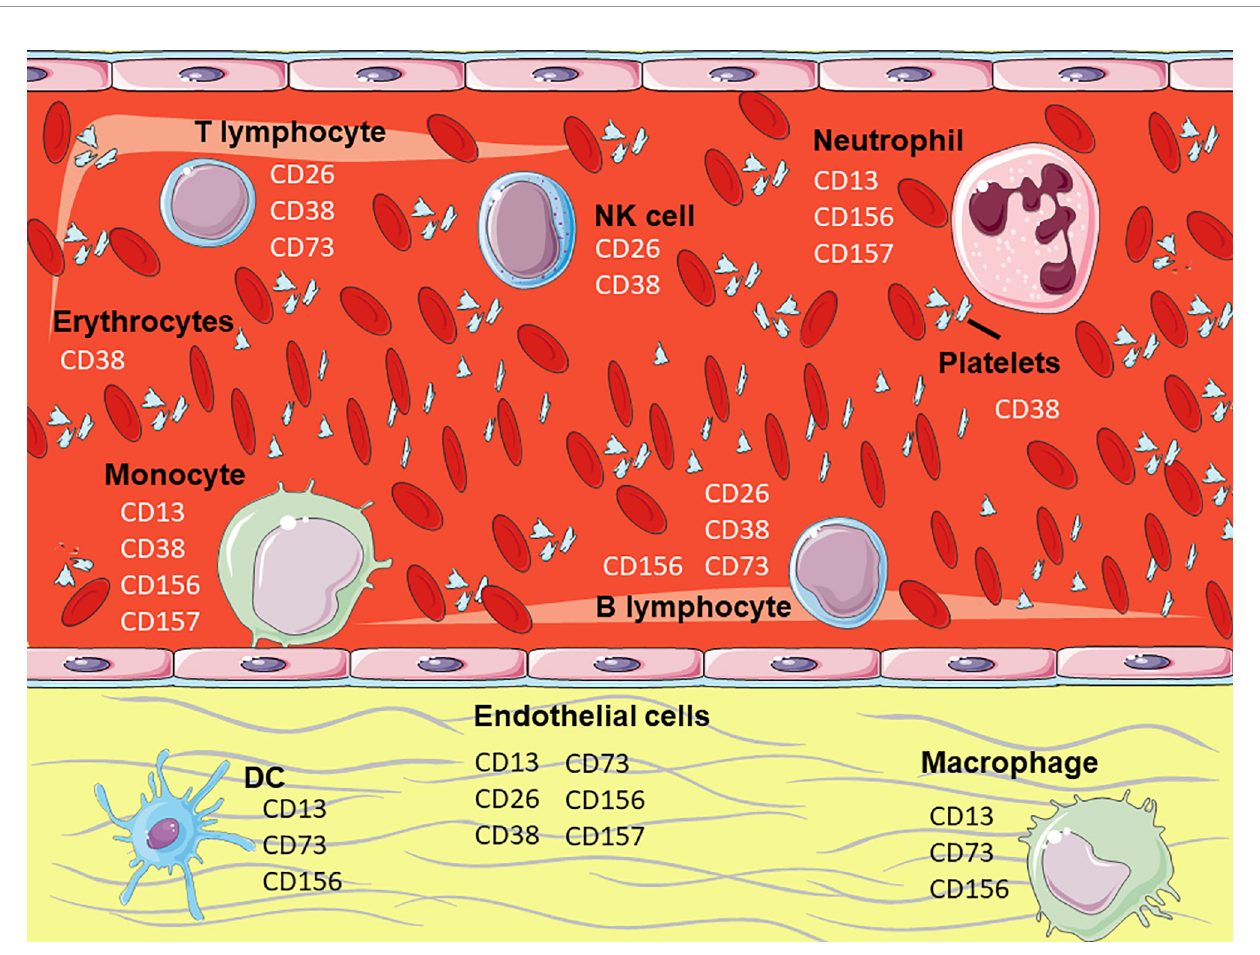
FIGURE 2 | Expression of the membrane enzymes on hematopoietic cells. Representation of hematopoietic and endothelial cells highlighting the membrane enzymes involved in cell adhesion. Figure designed using images from Servier Medical Art